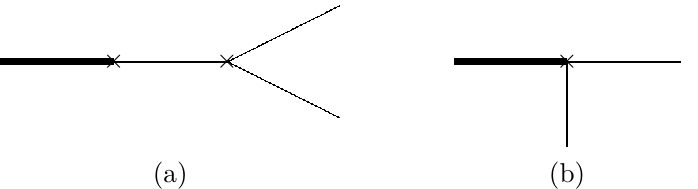
Figure 1 . This figure shows two elementary interaction vertices with zero dimensional moduli space. The thick lines denote closed strings and the thin lines denote open strings. A × represents disk amplitude. Figure (a) represent open-closed disk amplitude while figure (b) represents open- open-open disk